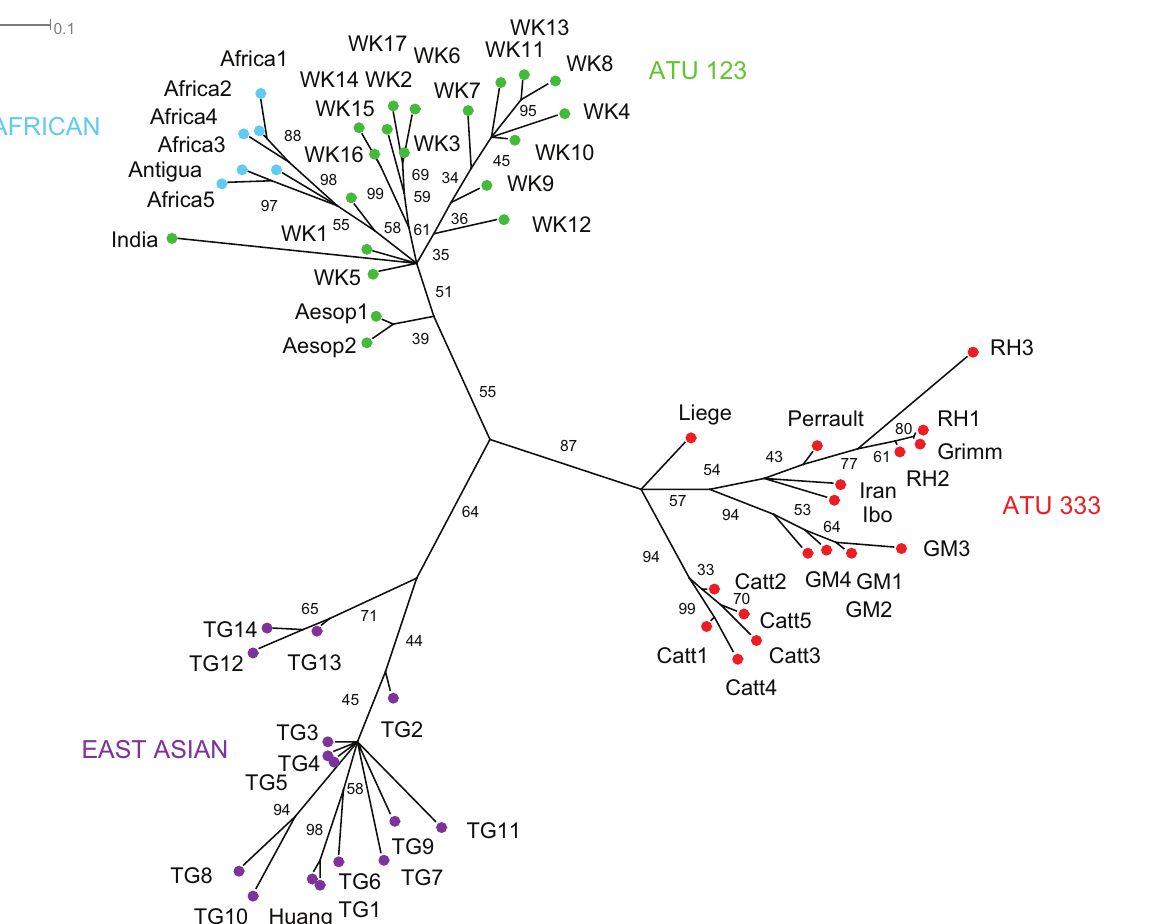
Figure 3. Maximum clade credibility tree returned by the Bayesian phylogenetic analysis of the tales. Major groupings are labelled by region and/or ATU international type and indicated by the coloured nodes. Numbers beside the edges represent the percentage of trees in the Bayesian posterior distribution of trees in which a given node occurred. The scale bar indicates the average number of changes per character along a given